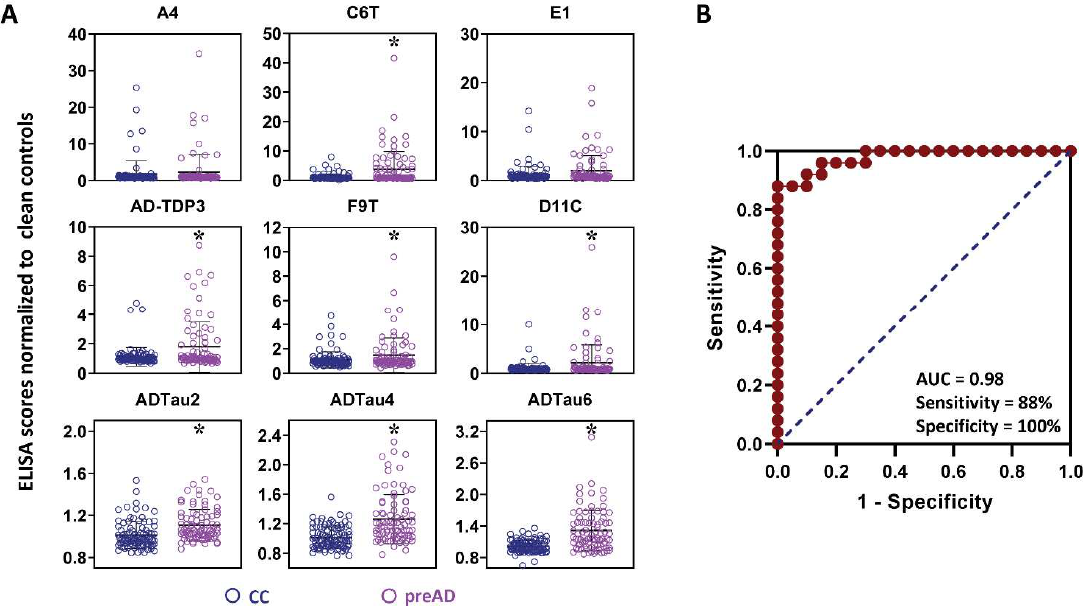
Figure 5. Comparison of plasma samples from preAD cases with 20 unflagged control cases ( A ) Levels of 9 different protein variants measured in preAD and 20 unflagged control samples. Significant differences were obtained with seven scFvs including: Aβ (C6T), TDP-43 (AD-TDP3), and tau (D11C, F9T, ADTau2, ADTau4, and ADTau6). Data represent mean average score and standard deviation with statistical significance by ANOVA post hoc LSD * p < 0.05. ( B ) ROC curve for 7 statistically significant scFvs (preAD screening panel) using averaged time point ELISA values for 25 preAD cases with AD and 20 unflagged control cases. From the AUC (0.98), an optimal cutoff threshold (10.82) was calculated by maximum Youden J value (0.88), with a sensitivity of 88% and specificity of 100%. CC denotes clean controls as unflagged control cases.